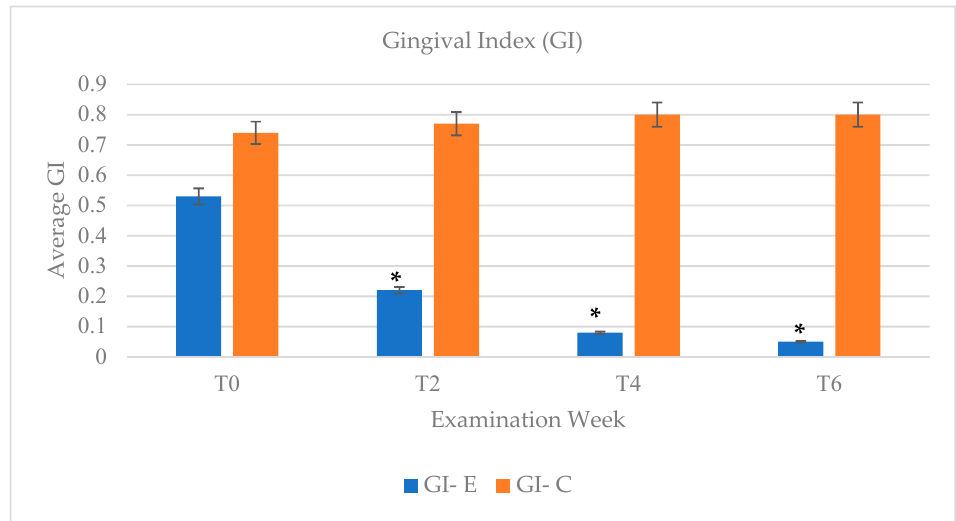
Figure 6. GI measurements were compared between experimental group (E) and control group (C) and categorized by examination week. Each bar represents an average GI score of each group at each evaluation week. The GI measurements received a κ of 0.758 and inter-examiner agreement of 91%. (T0—baseline/week 0; T1—week 1; T2—week 2; T4—week 4; T6—week 6) (* p < 0.05).